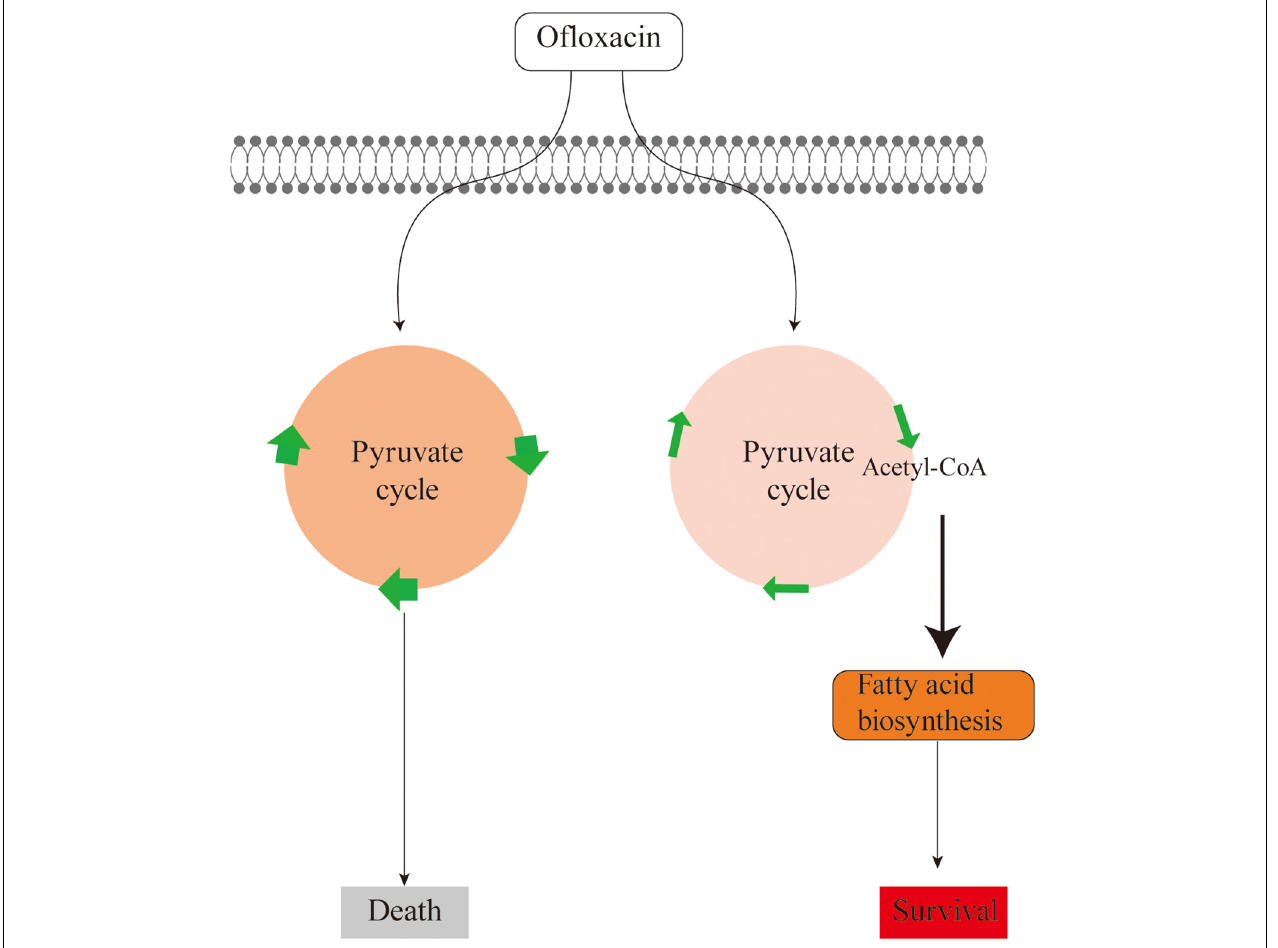
FIGURE 8 | Sketch diagram describing a mechanism by which V. alginolyticus adapts to antibiotic